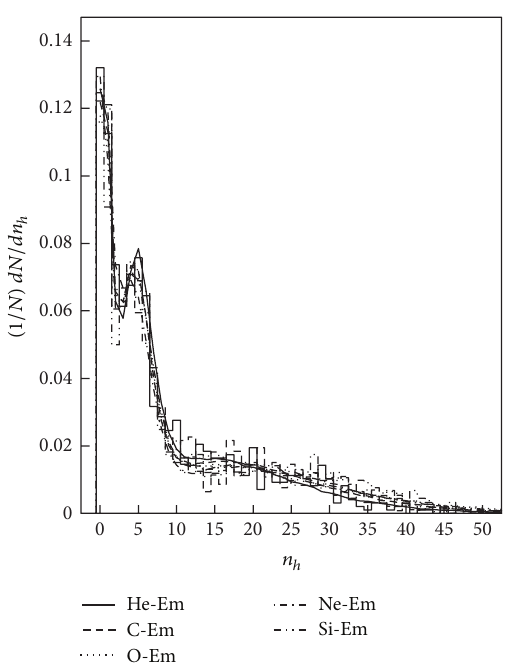
Figure 4: Normalized multiplicity distributions for heavy particles produced in the interactions of projectiles with Em at (4.1–4.5) AGeV/c. The histograms represent the experimental data, while the curves are the corresponding ones calculated according to the multisource thermal model.